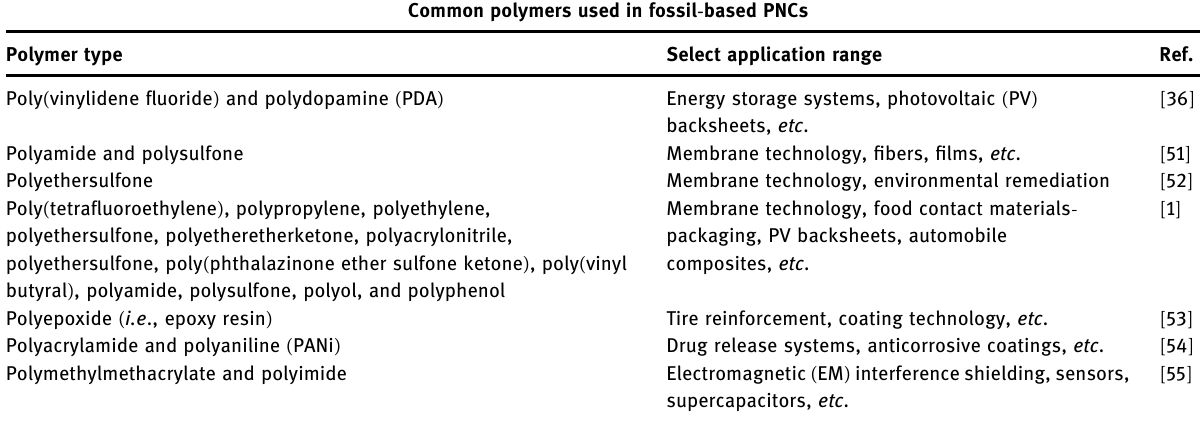
Table 2: Commonly employed polymers for PNC fabrication with the corresponding application areas Common polymers used in fossil - based PNCs Polymer type Select application range